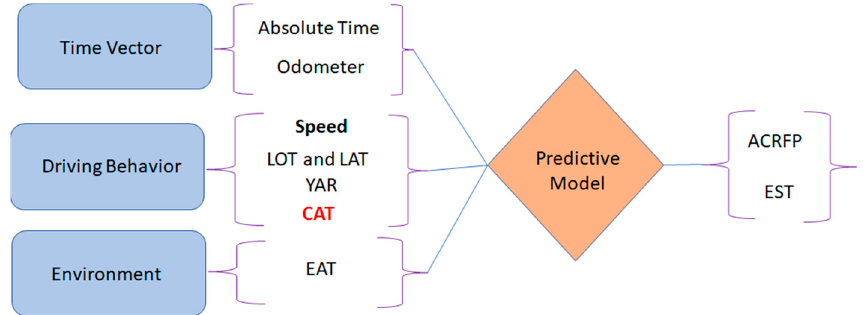
Figure 2. NARX DL Model—Inputs and Outputs [13].